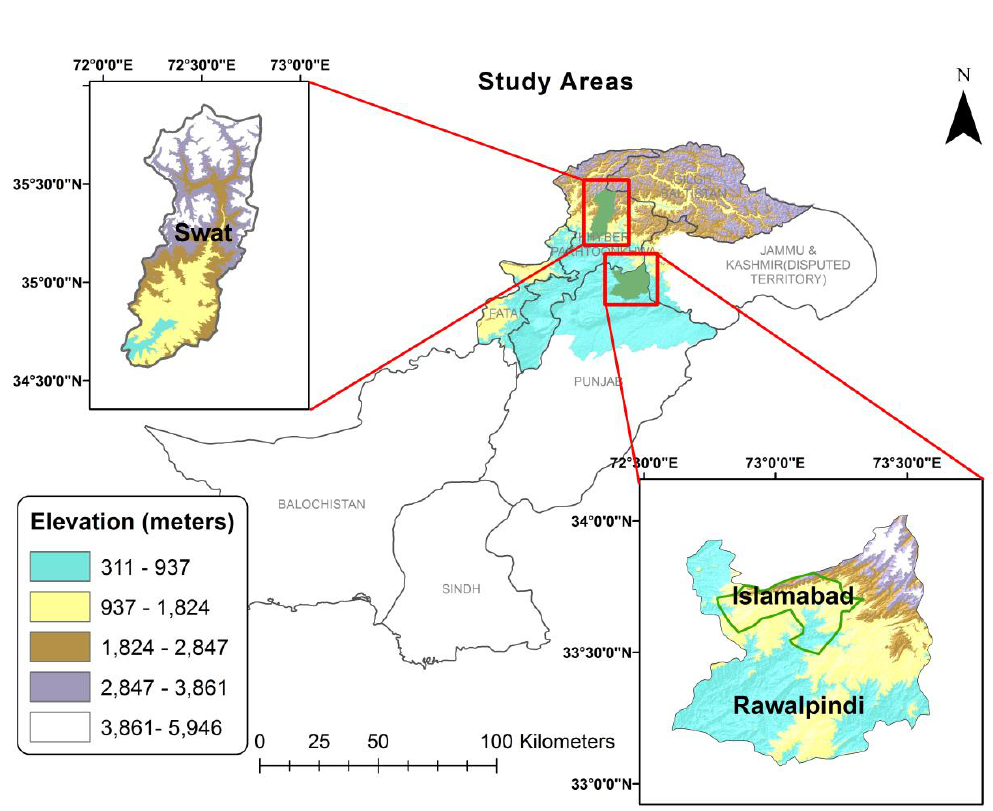
Figure 1. Location map of the two study areas, Rawalpindi-Islamabad Punjab and Swat.